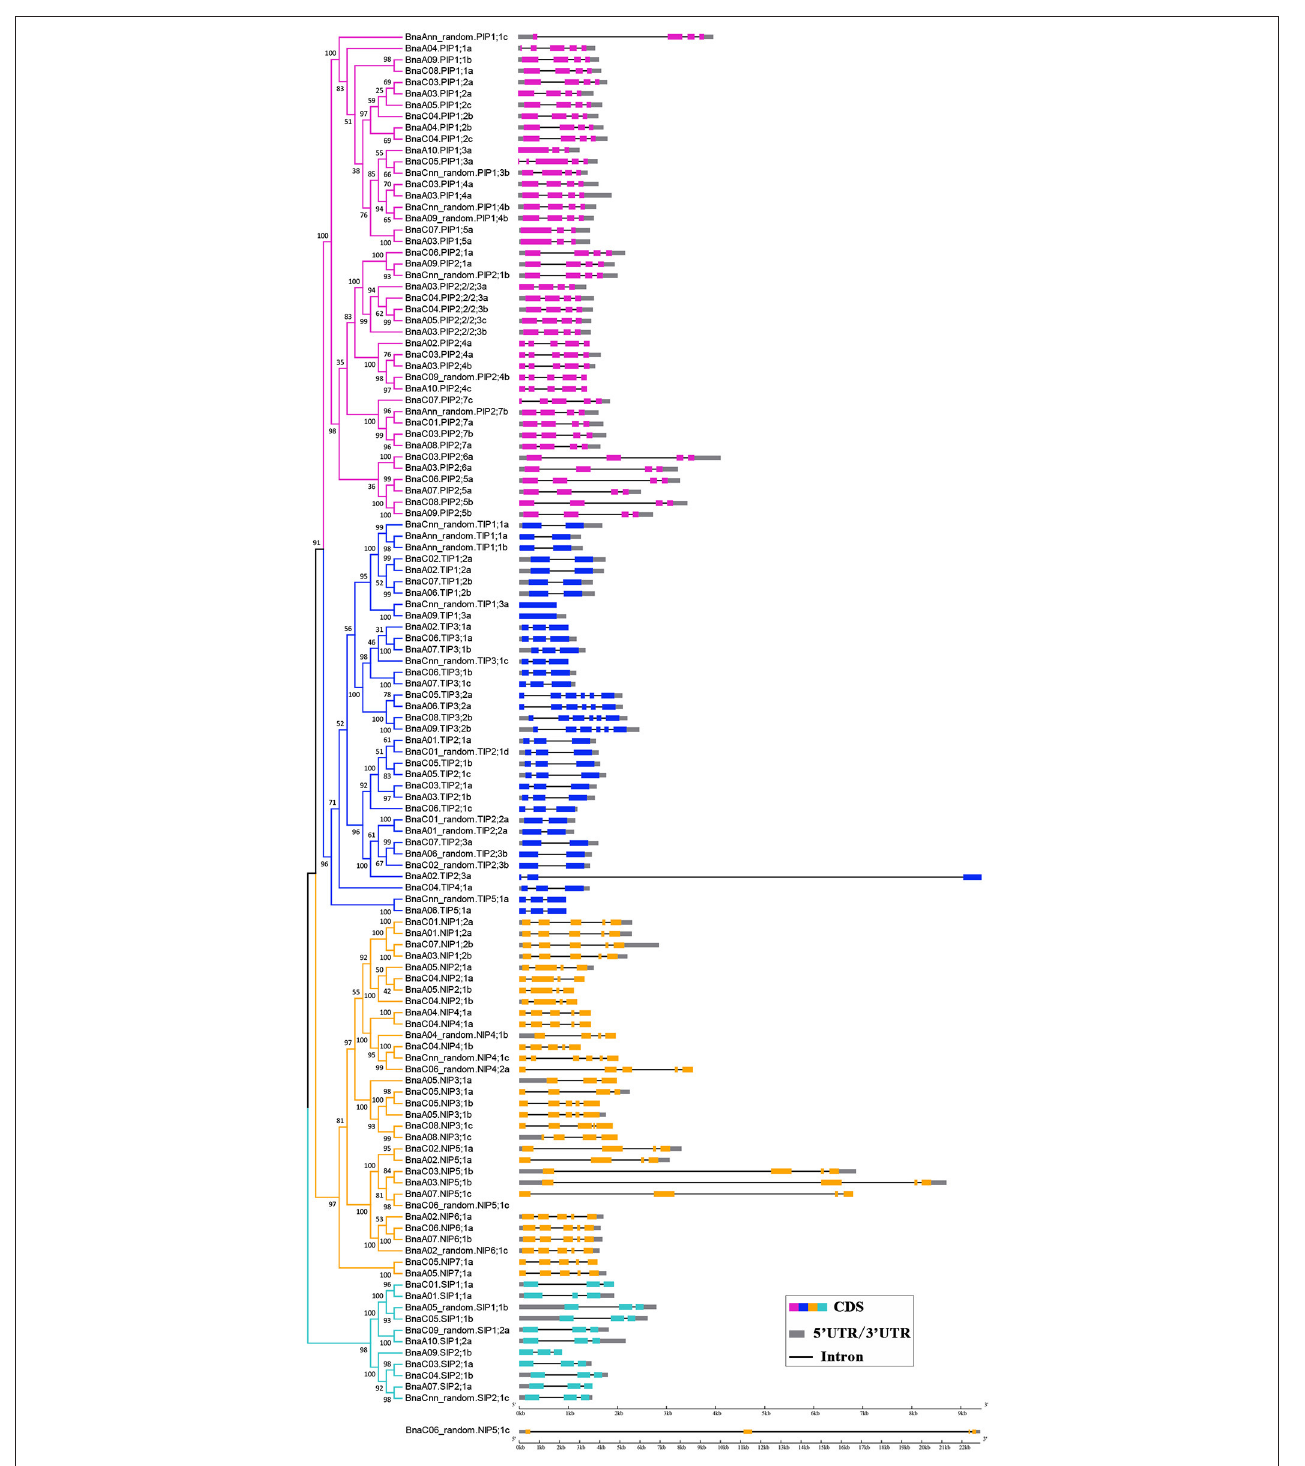
FIGURE 3 | Gene structure of BnaAQP s. The exon-intron structures of the BnAQP s were determined by the alignments of coding sequences with corresponding genomic sequences, and the diagram was obtained using GSDS (Gene Structure Display Server 2.0) Web server. The purple, blue, yellow, and cyan rectangles represented the exons of BnaPIP s, BnaTIP s, BnaNIP s, and BnaSIP s, the gray rectangles represented the UTR and the black lines represented the introns, respectively. BnaC06_random.NIP5;1c was list alone because it had the longest gene length.